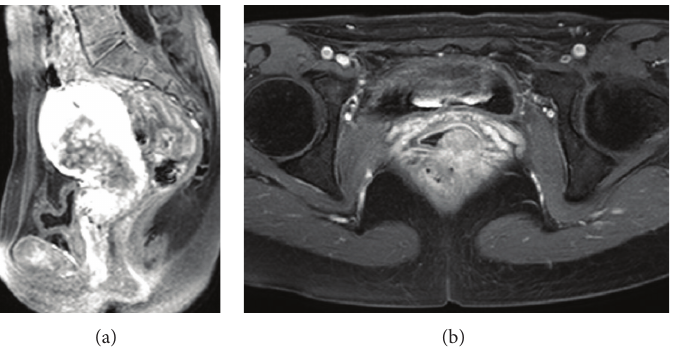
Figure 2: Pelvic MRI. (a) Sagittal fat-suppressed T1-weighted MR image after gadolinium administration showed region heterogeneously poor enhanced in cervix, vagina, and uterine corpus myometrium which were irregularly enhanced in late phase. (b) Axial fat-suppressed T1- weighted MR image after gadolinium administration showed cervical mass homogeneously enhanced in the posterior wall from the uterine cervix to the